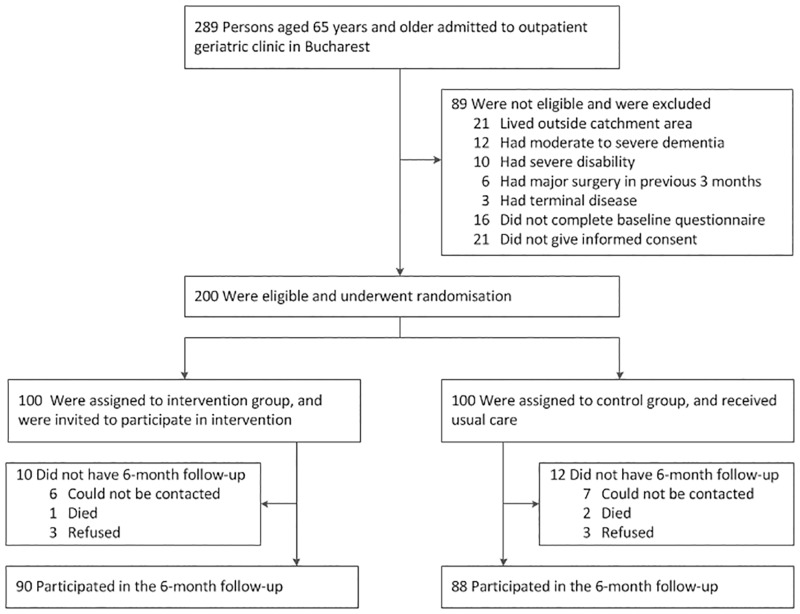
Study CONSORT flow diagram.